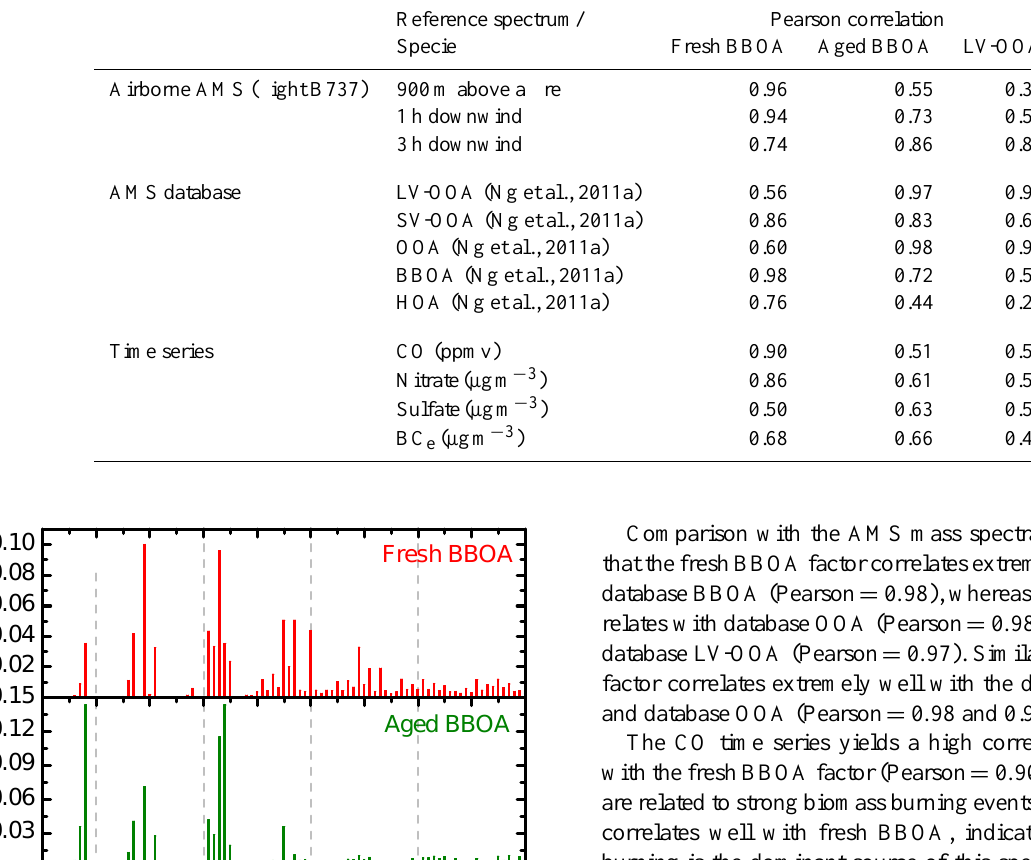
Table 3. Correlation analysis of the OA factors relative to their spectra and time series. Airborne AMS refers to the aircraft component of SAMBBA (see Supplement).